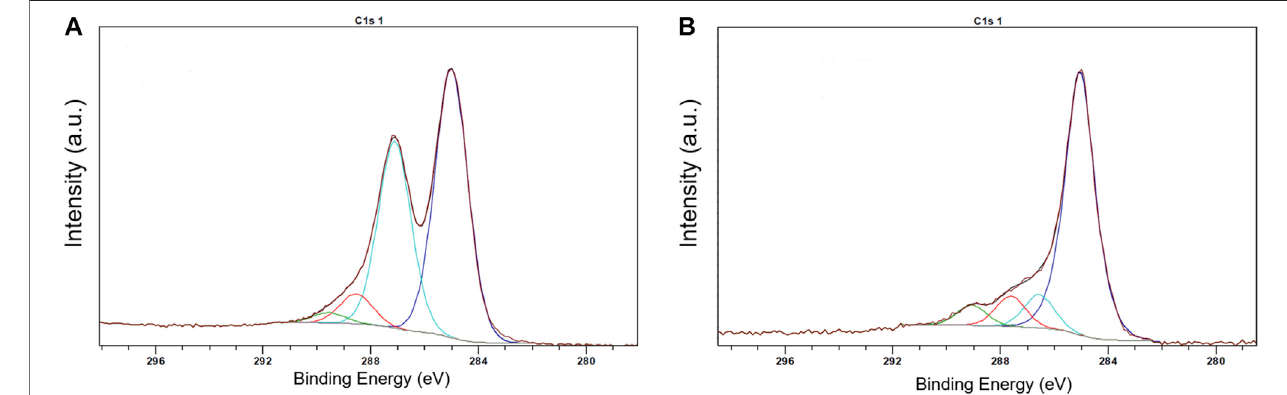
FIGURE 3 | XPS spectra of GO (A) and ERGO (B) .